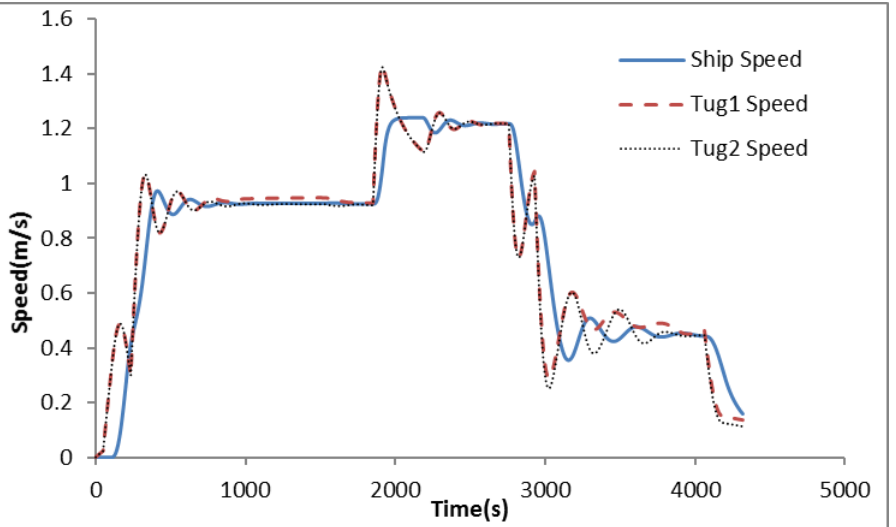
Figure 17. The position of tugboats during the towing process.